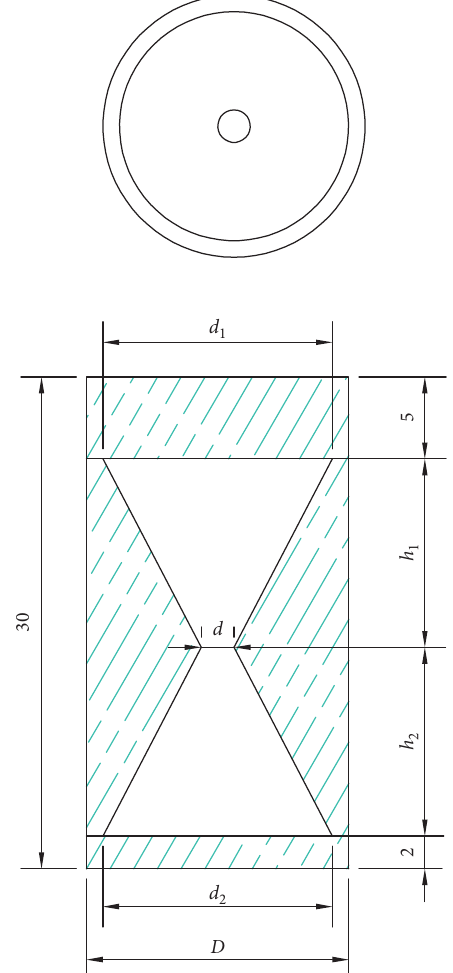
Figure 3: Schematic diagram of the single cell structure of the sound insulation material with the combined